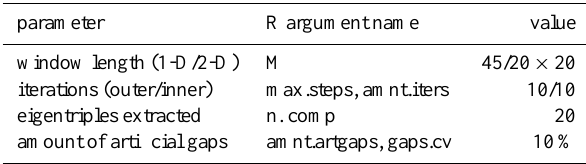
Table 1. Overview of the parametric choices used for the test runs and their respective argument names in the GNU-R code.